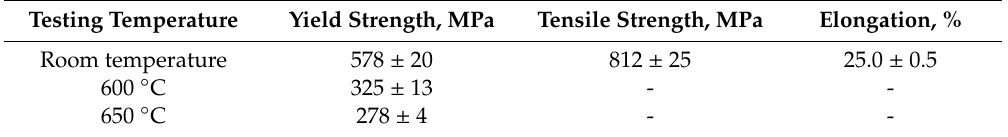
Table 1. Tensile properties of the hot rolled steel at room temperature and elevated temperatures. Testing